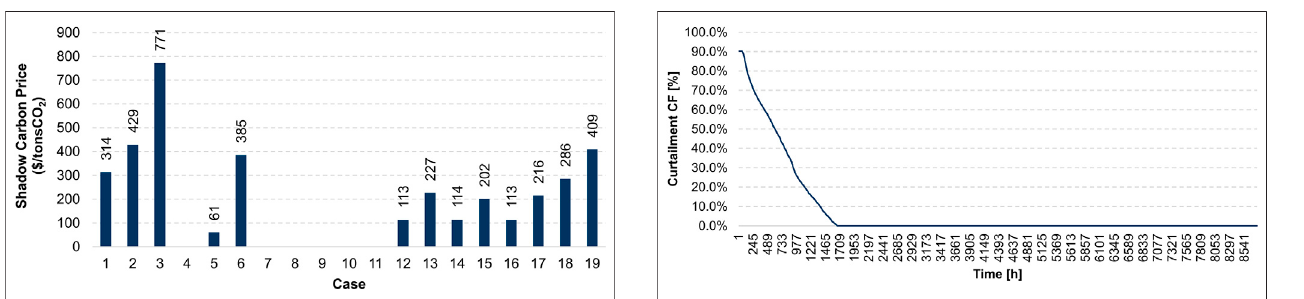
FIGURE 11 | Shadow carbon price for the different